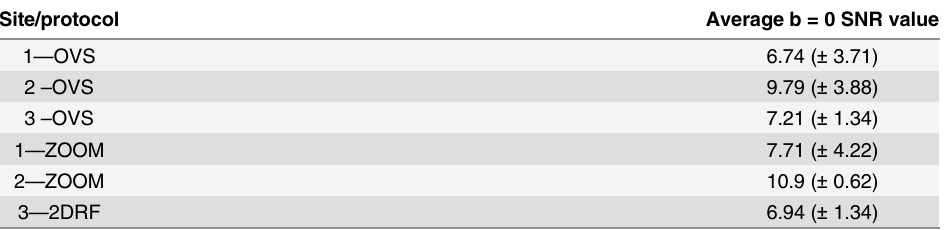
Table 2. Average SNR values for each site and protocol, calculated from two b = 0 images for each subject, using the “ difference method ” [34] in whole cord ROI